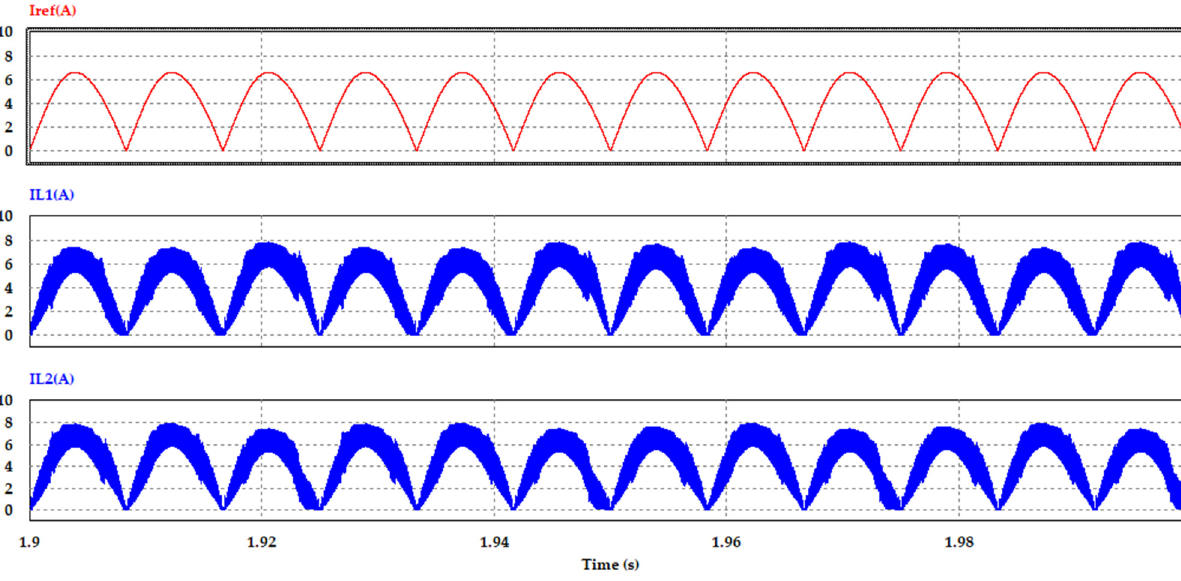
Figure 17. Inductors current and reference current for the interleaved CCM PFC at full load condition.